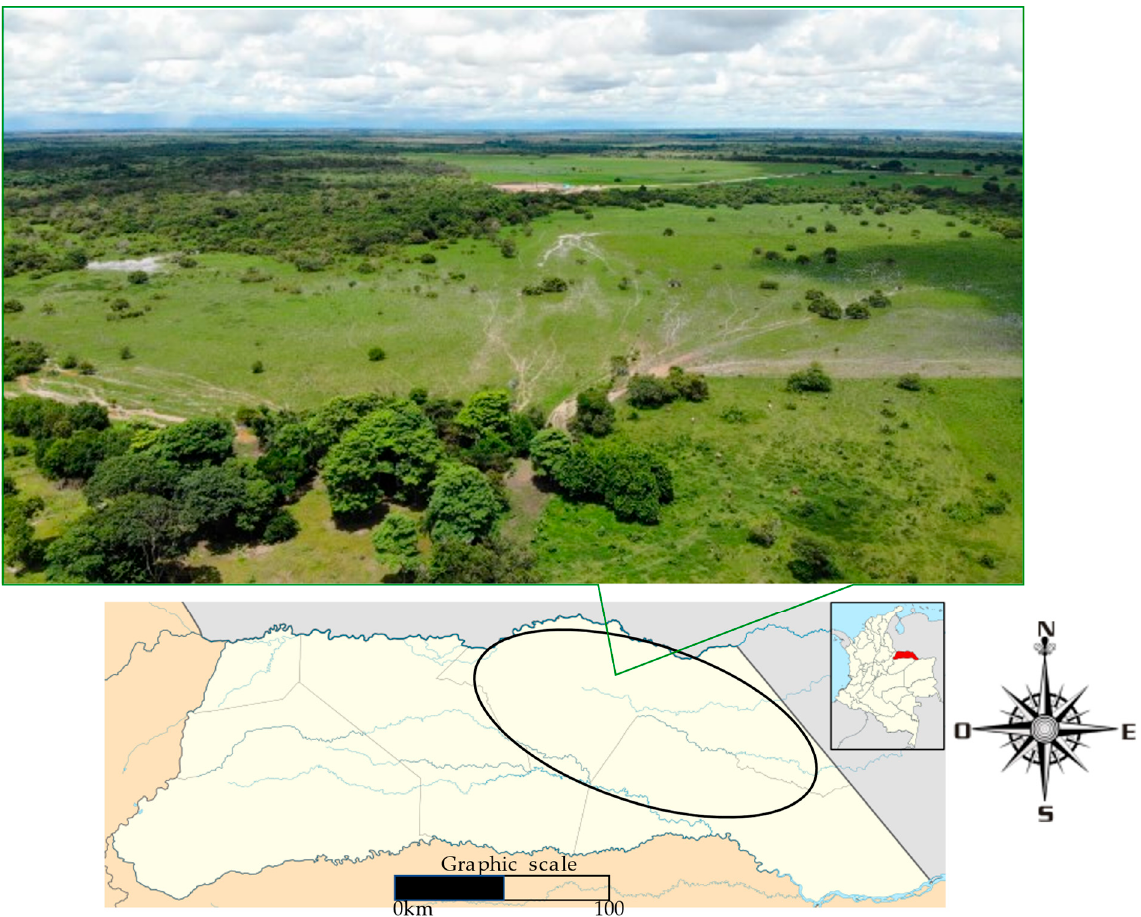
Figure 1. Department of Arauca in eastern Colombia. Circle: savannah floodplain agroecosystem, department of Arauca. Red color: location of the department of Arauca, eastern Colombia. Above photograph: savannah floodplain agroecosystem, eastern Colombia (latitude: 07° 08 ′ 17 ″ N, longitude: 70° 59 ′ 59 ″ W). Physiographic position of “bank”. They are high areas with a convex surface, of variable length and width, parallel to the natural drainages of the flood plain (Figure 3).